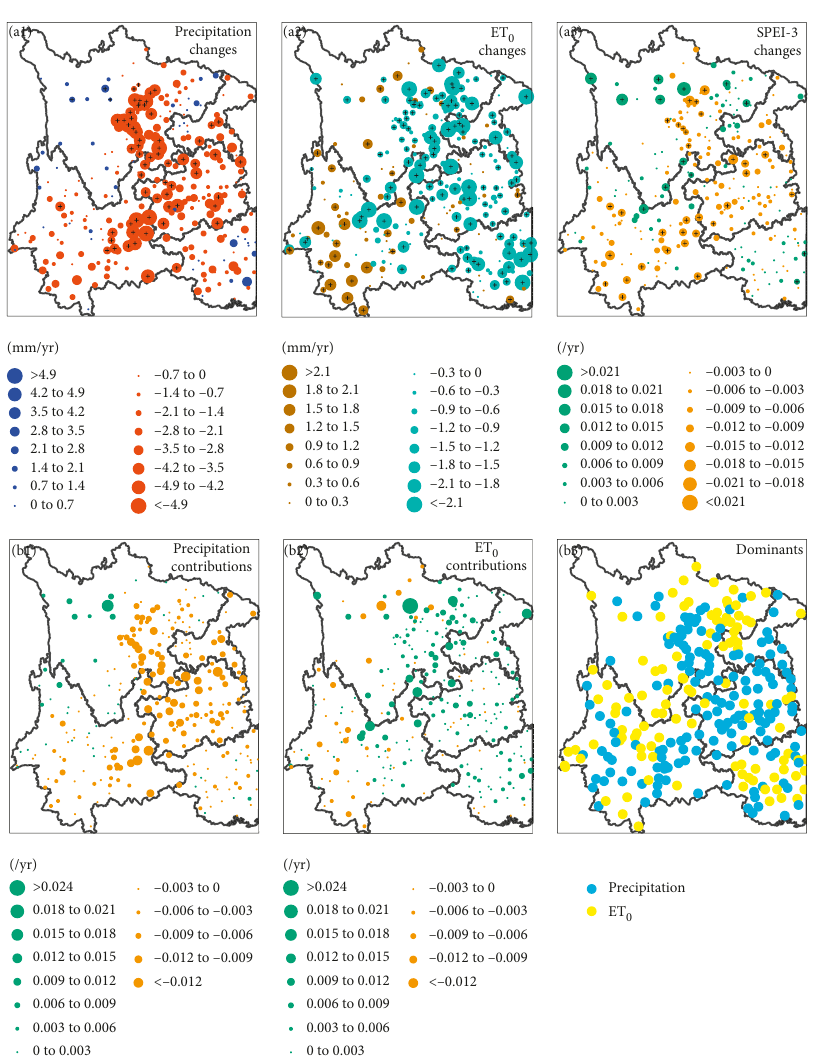
Figure 3: Annual spatial distributions of precipitation, ET 0 , and SPEI-3 changes (a1–3) and precipitation and ET 0 alone contributions to SPEI-3 trends (b1–2) with dominants (b3) during 1961–2012. The plus sign denotes that trend is